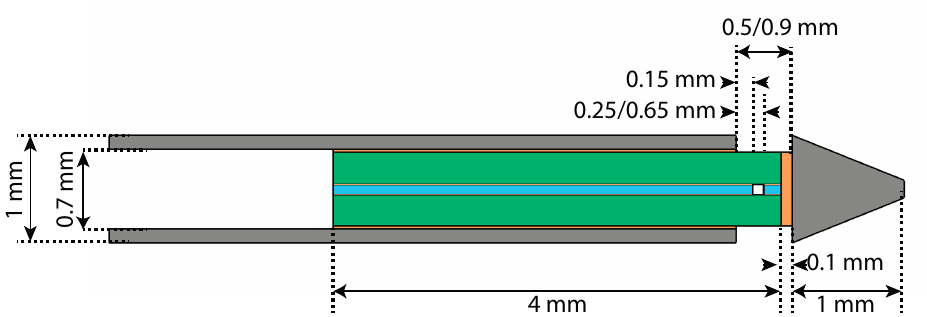
Figure 4. Cross-section of the geometry of the quartz capillary concept. The metal stylet tube and needle tip are shown in grey, the quartz ferrule in green, the glue layers in orange and the silica optical fiber in blue. The thickness of the glue layer used to fixate the optical fibers in the borehole of the quartz ferrule is enlarged for illustrative purposes. The FPI-cavity length was varied between 100µm and